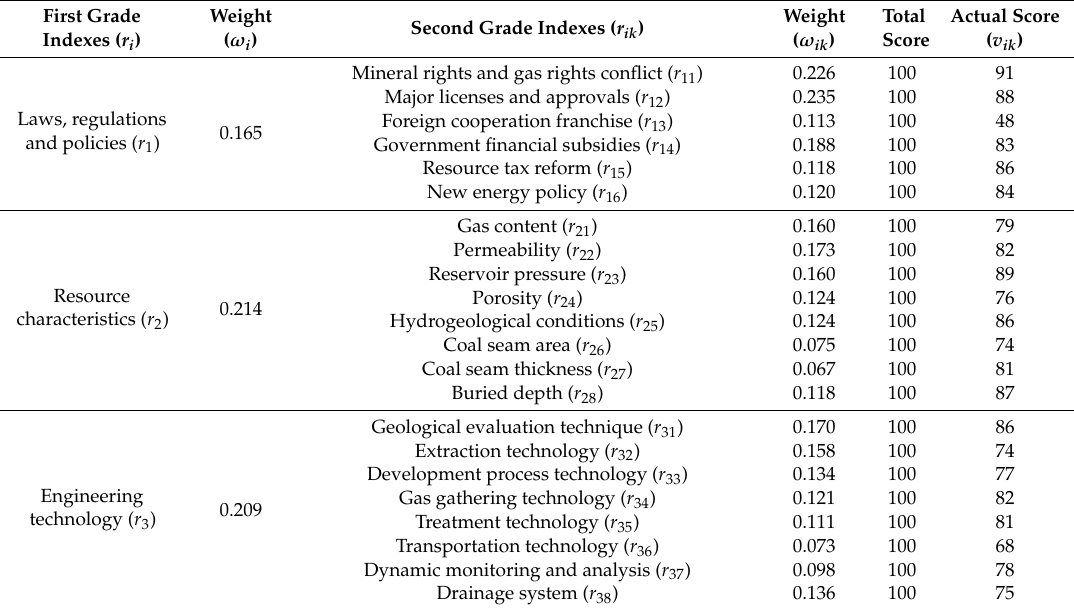
Table 4. Index weights and actual